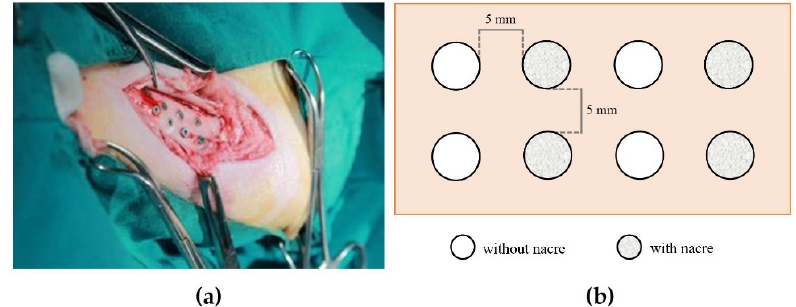
Figure 7. ( a ) A photograph showing dental implants surgically placed in a tibia. ( b ) Schematic drawing of dental implant placement design in the tibia of each